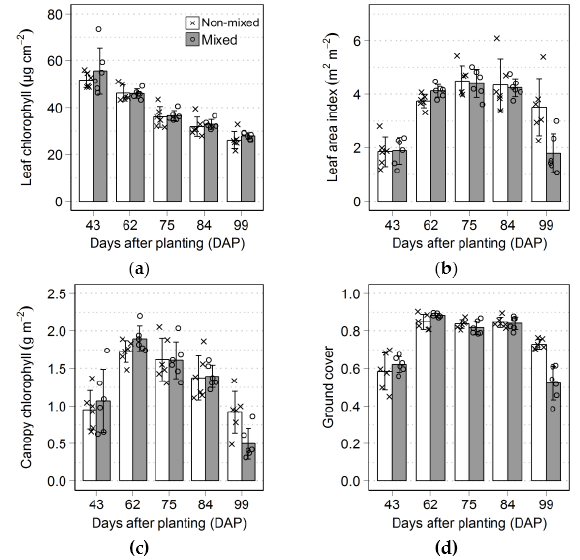
Figure 3. Vegetation properties at plot level for both production systems (i.e., non-mixed and with mixed varieties) over time (from 43 to 99 DAP): ( a ) Leaf chlorophyll content; ( b ) Leaf area index; ( c ) Canopy chlorophyll content; and ( d ) Ground cover. Dots represent observations for each treatment and error bars the standard deviation. Sensors 2017 , 17 , 6